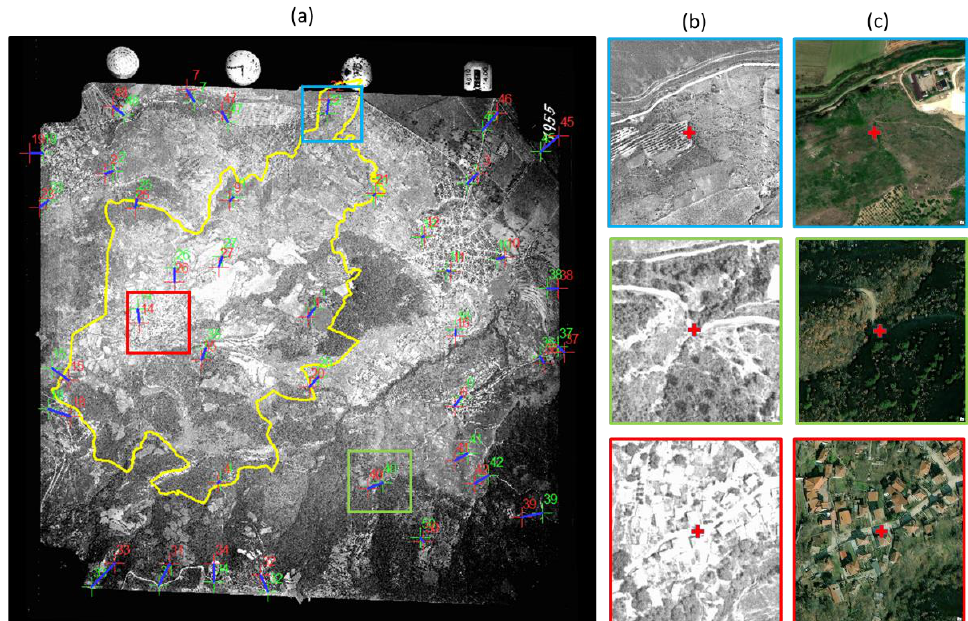
Figure 3. ( a ) Distribution of GCPs on the 1975 aerial photo and examples of GCPs selection (red crosses) on ( b ) aerial photographs and their counterparts on ( c ) Google Earth, image indexed by colored boxes on the image (yellow vector shows the boundaries of the Ruen village).